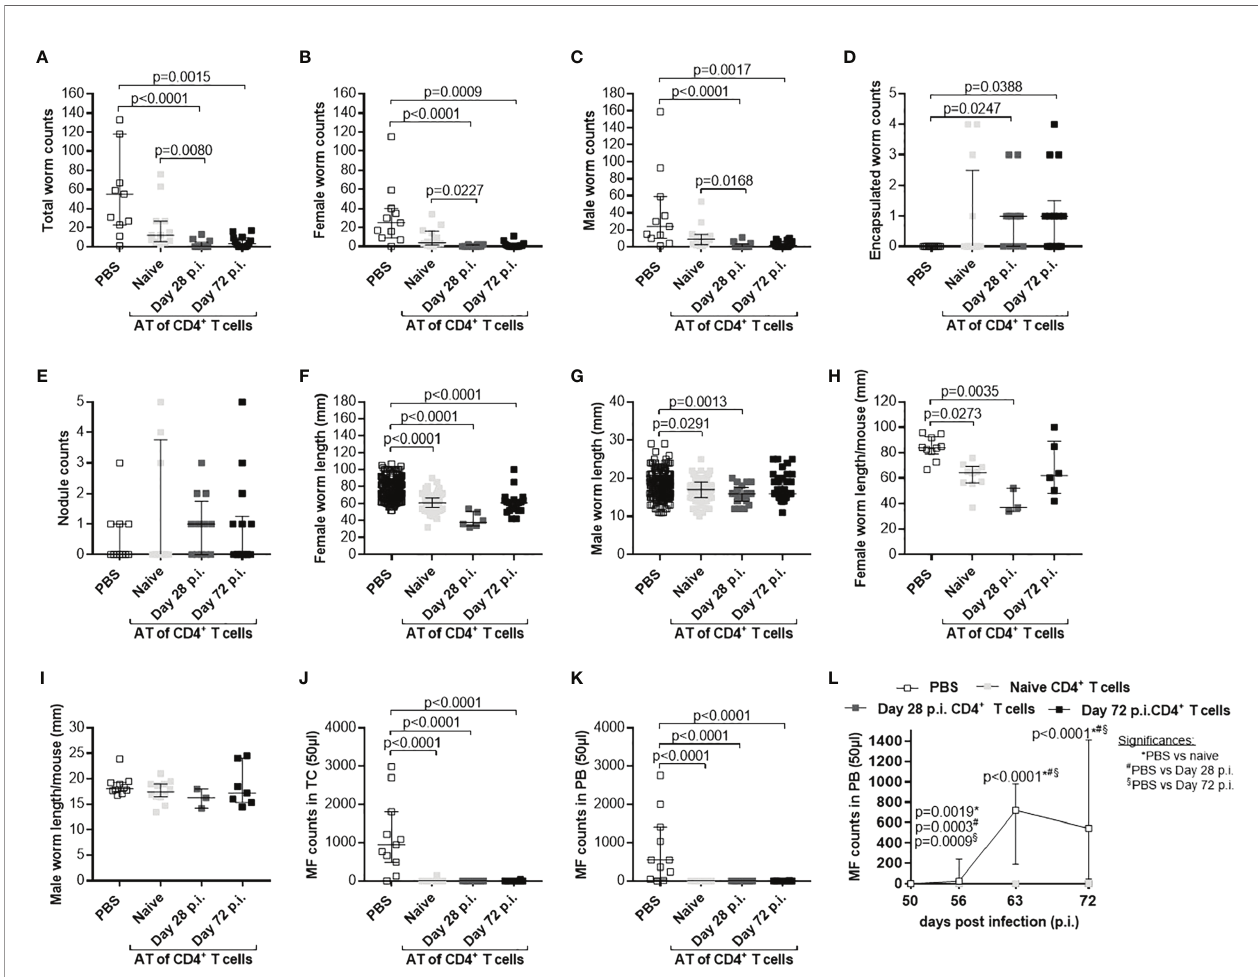
FIGURE 6 | Comparable ef fi cacy of CD4 + T cells isolated from day 28 or 72 L. sigmodontis -infected C57BL/6 donor mice. CD4 + T cells from C57BL/6 donor mice that were either naïve or infected with L. sigmodontis for 28 or 72 days were injected intravenously (i.v.) into the tail vein of RAG2IL-2R g -de fi cient C57BL/6 mice one day prior to L. sigmodontis infection. On day 72 p.i. mice were analysed to assess (A) total, (B) female, (C) male and (D) encapsulated worm counts as well as (E) nodule counts in the thoracic cavity (TC). Moreover, individual (F) female and (G) male worm length and (H) female and (I) male worm length per mouse were measured. Finally, micro fi laria (MF) counts were determined in the (J) TC and (K) peripheral blood (PB) and (L) during the course of infection upon 50 days p.i. in PB. (A – L) Graphs show dot blots with median and interquartile ranges from individual mice from two independent experiment including no adoptive transfer (PBS; n=11) and adoptive transfer of CD4 + T cell from naïve donor mice (n=12) or donor mice that were infected with L. sigmodontis for 28 days (n=12) or 72 days (n=14) into RAG2IL-2R g -de fi cient C57BL/6 mice. Signi fi cant differences between the groups were determined by Kruskal-Wallis-test followed by a Dunn ’ s multiple comparison test. AT, adoptive